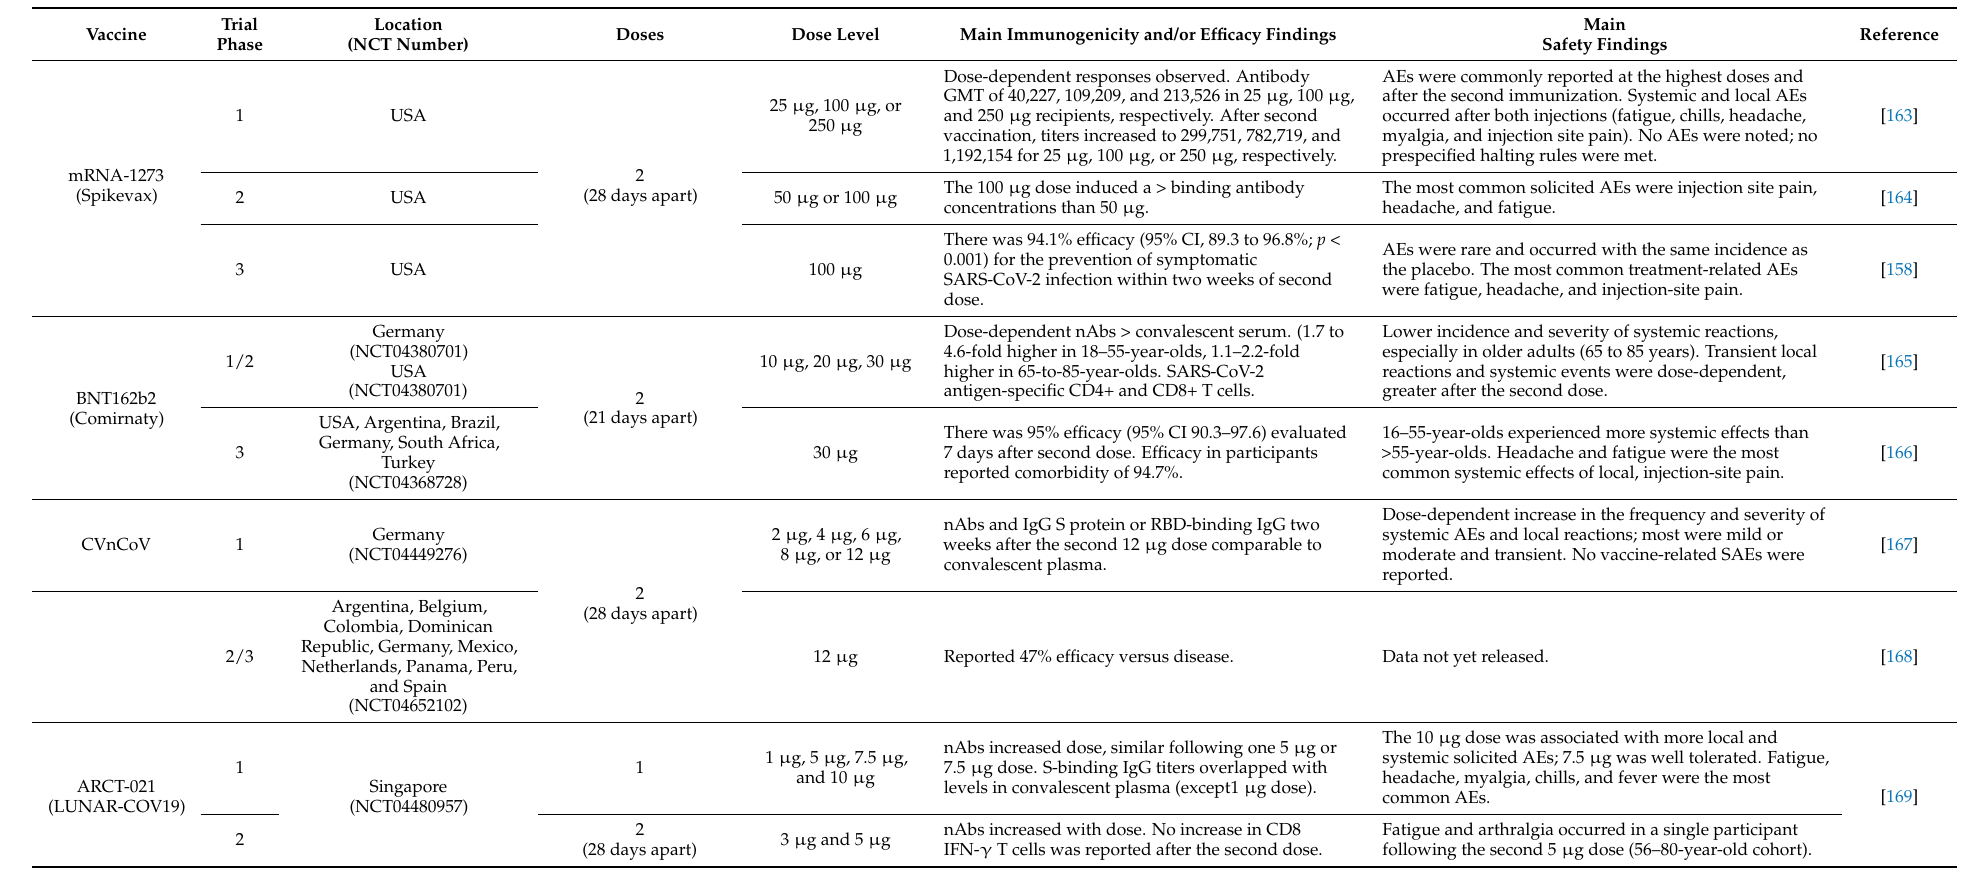
Table 4. Overview of clinical trials involving the most advanced COVID-19 RNA